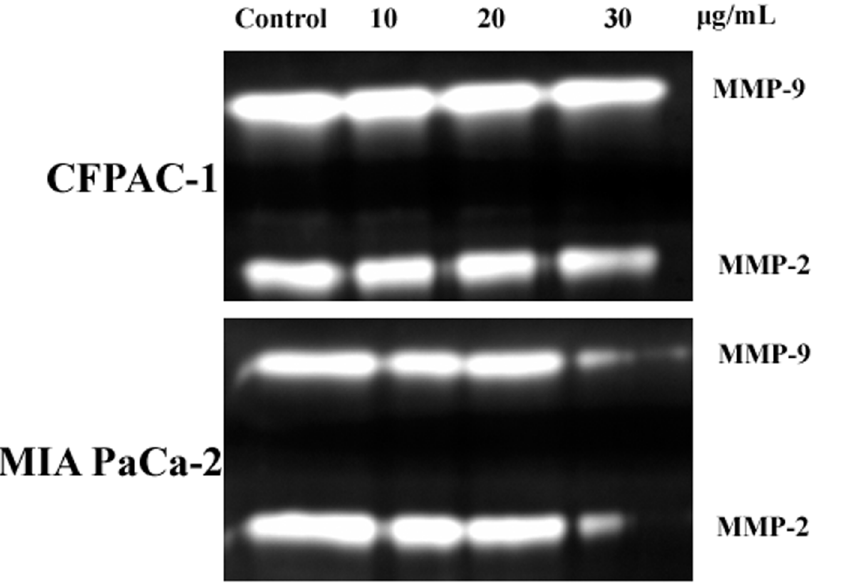
Figure 8. The gelatinase activity alterations of MMP-2/9 in both cells were assessed by a gelatin zymography assay. Gelatin zymography of both CFPAC-1 and MIA PaCa-2 cells was carried out by subjecting conditioned media samples to 10% SDS-PAGE containing 1 mg/mL of gelatin and then stained with 0.25% Coomassie brilliant blue R-250.